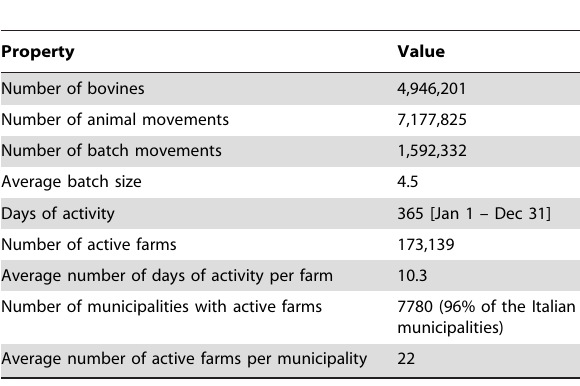
Table 1. Cattle trade movements: Data from the Italian National Bovine database for the year